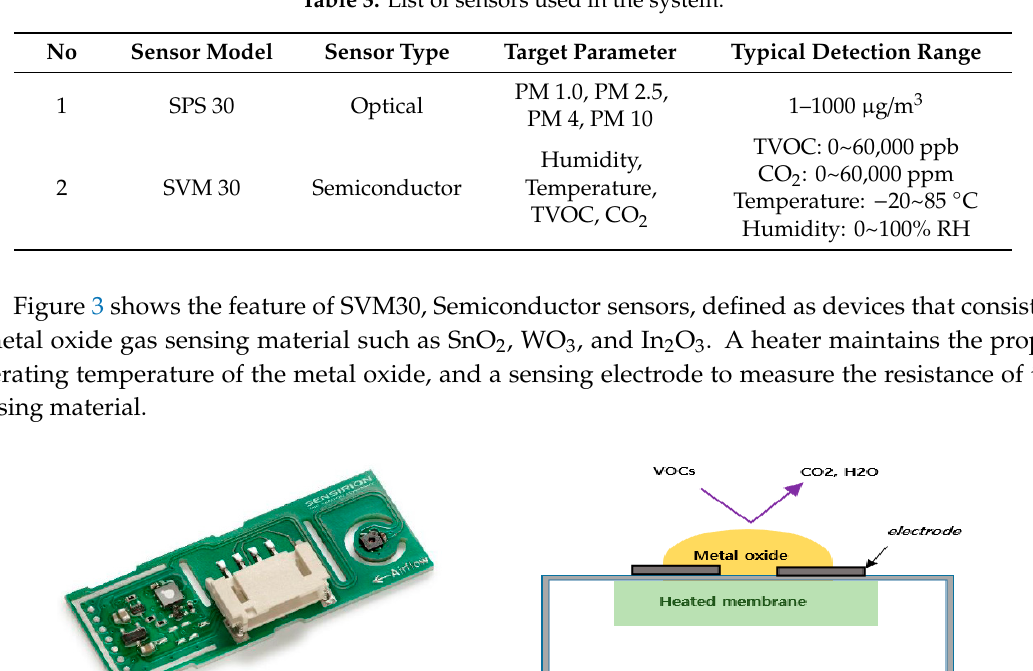
Table 3. List of sensors used in the system.